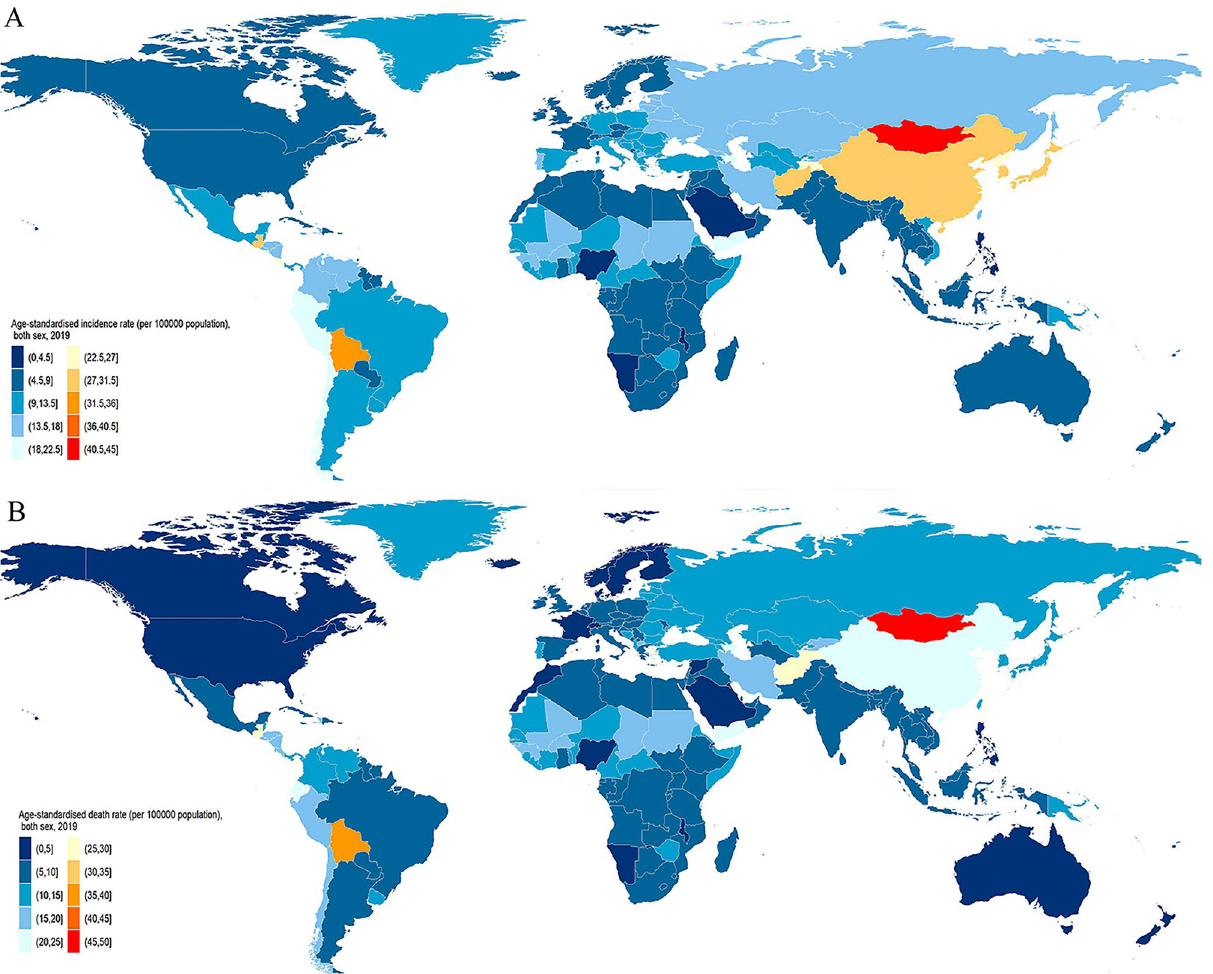
Figure 1. Age-standardized incidence ( A ) and death ( B ) rates of stomach cancer per 100,000 population both sex, 2019. Maps were generated using R software (version 4.0.3) and ggplot2 package. [R Core Team (2019). R: A language and environment for statistical computing. R Foundation for Statistical Computing, Vienna, Austria. URL https:// www.R- proje ct. org; and (H. Wickham. ggplot2: Elegant Graphics for Data Analysis. Springer-Verlag New York, 2016. URL https:// https:// ggplo t2. tidyv erse.